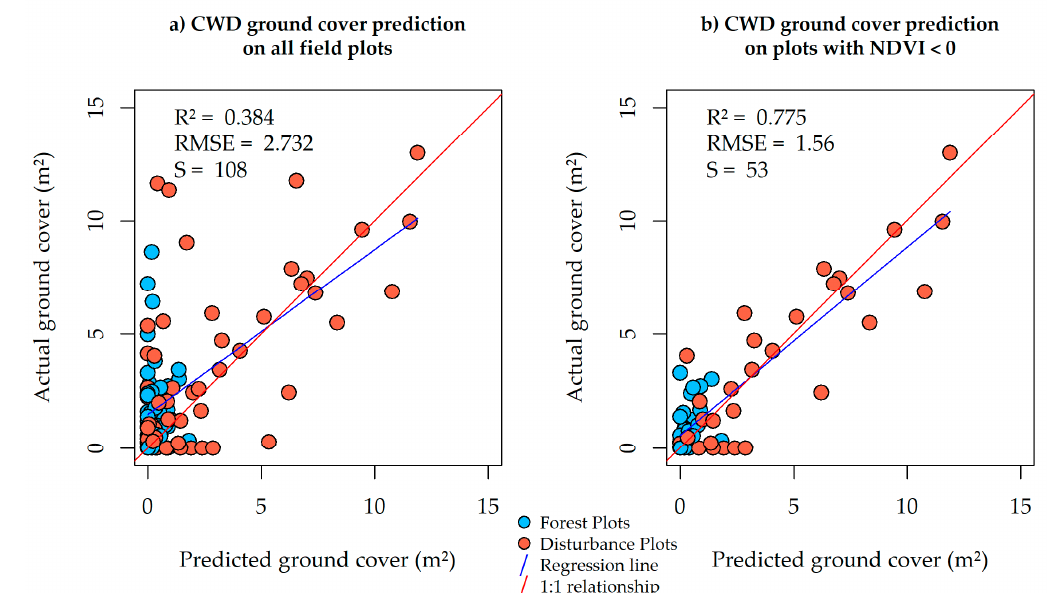
Figure 7. Scatter plots of actual versus predicted coarse woody debris (CWD) ground cover in m 2 . Predicted ground cover presented here is the area sum of CWD objects detected via image-analysis. A weak relationship is observed when ( a ) all field plots are used in regression, and a much stronger relationship is observed in ( b ) plots with negative average normalized-difference vegetation index (NDVI).